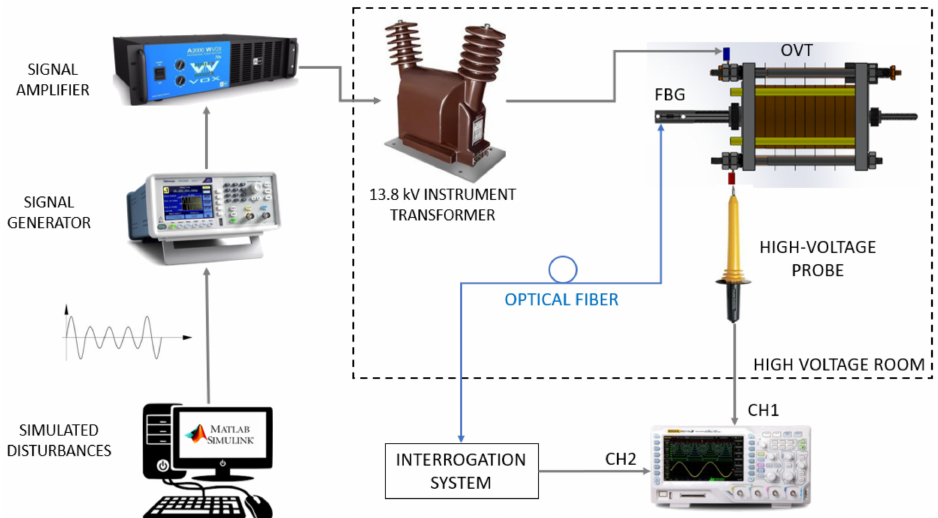
Figure 5. Experimental set-up for power quality measurements. Dotted box represents the high voltage cubicle. The interrogation system is show in Figure 4.